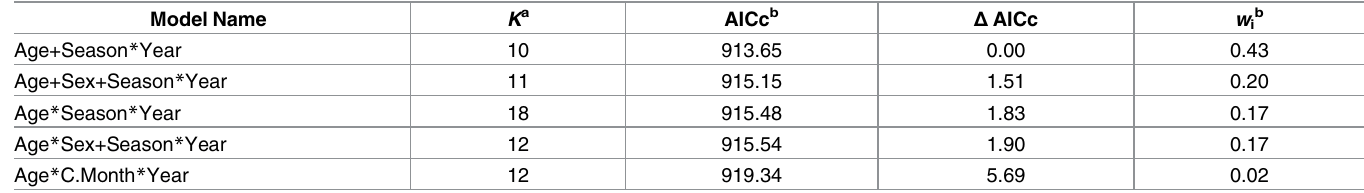
Table 2. Results from GLM logistic regression models predicting variation in influenza A virus prevalencefor mallards sampled in Fairbanks and Anchorage, Alaska from August through April of 2012–2015. Model